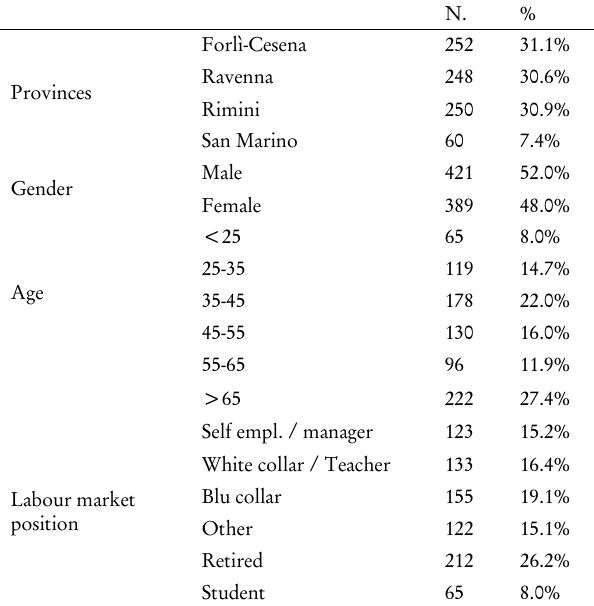
Profile of Respondents